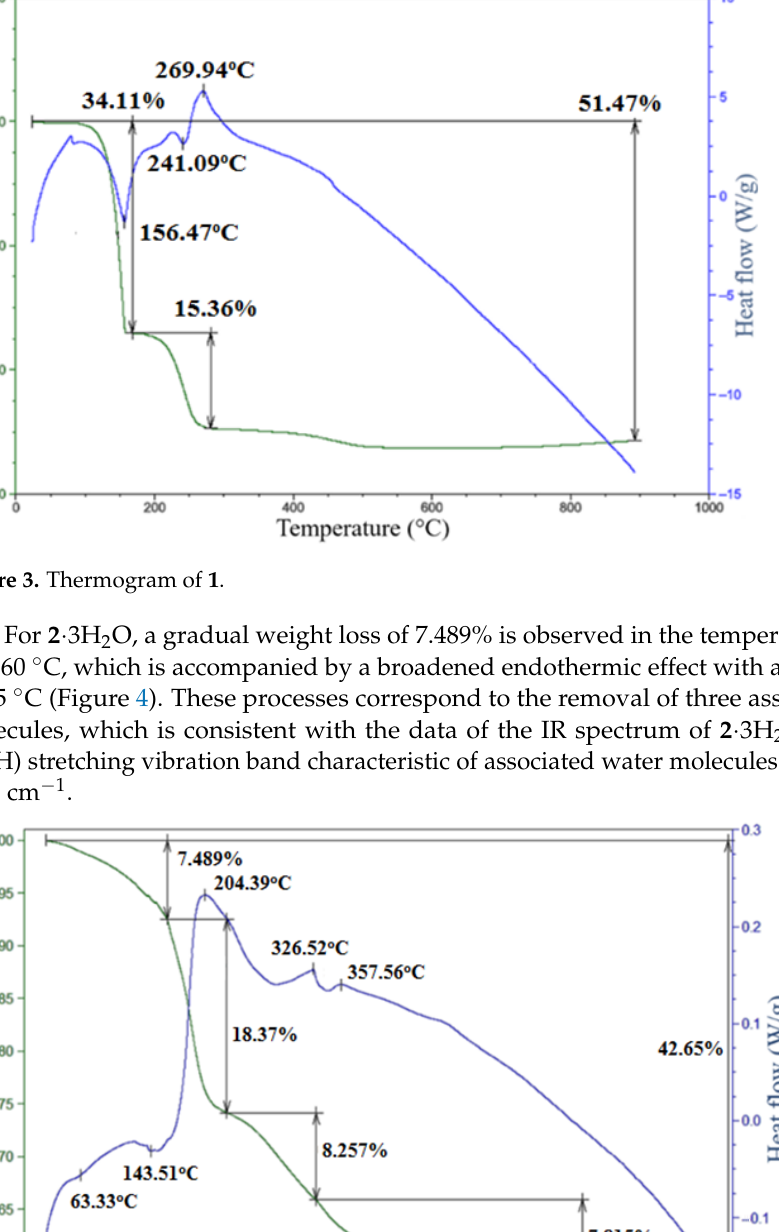
Figure 3. Thermogram of 1 .